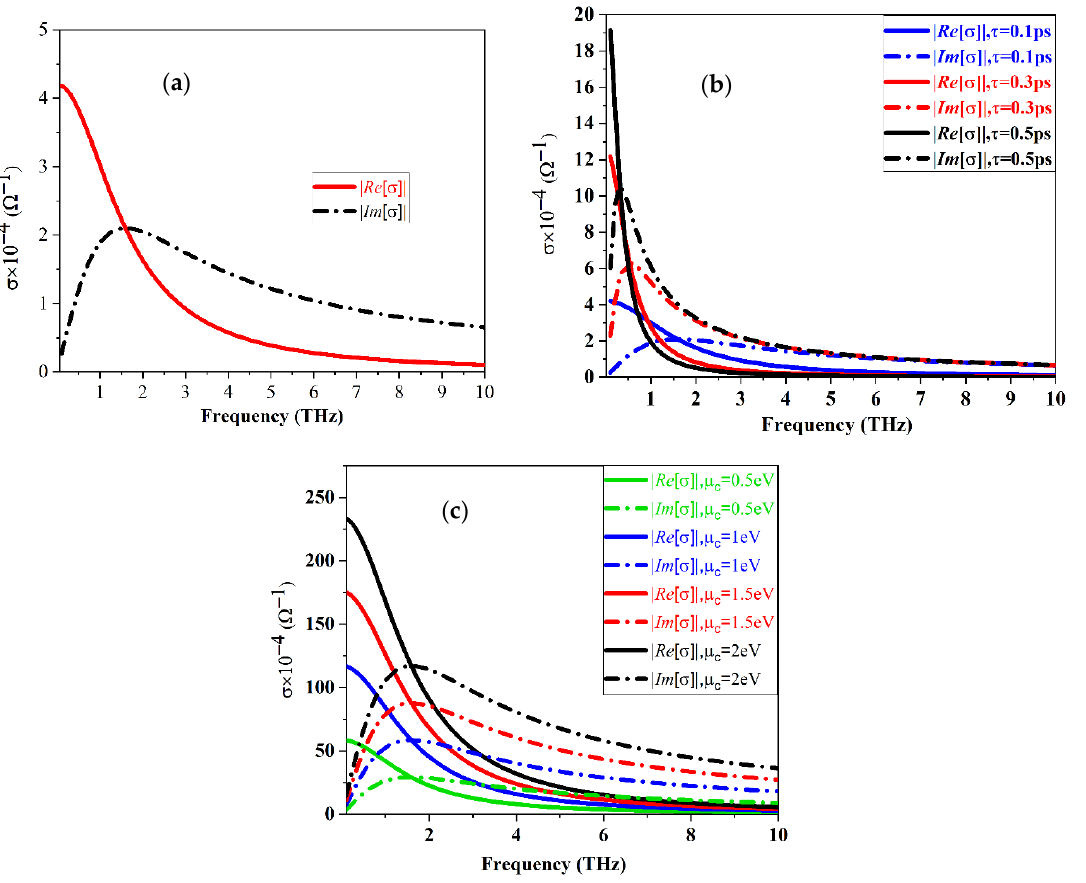
Figure 1. Surface conductivity of graphene for ( a ) μc = 0 eV and τ = 0.1 ps, ( b ) different relaxation times at μc = 0 eV, and ( c ) different chemical potential values at τ = 0.1 ps T = 300 K.